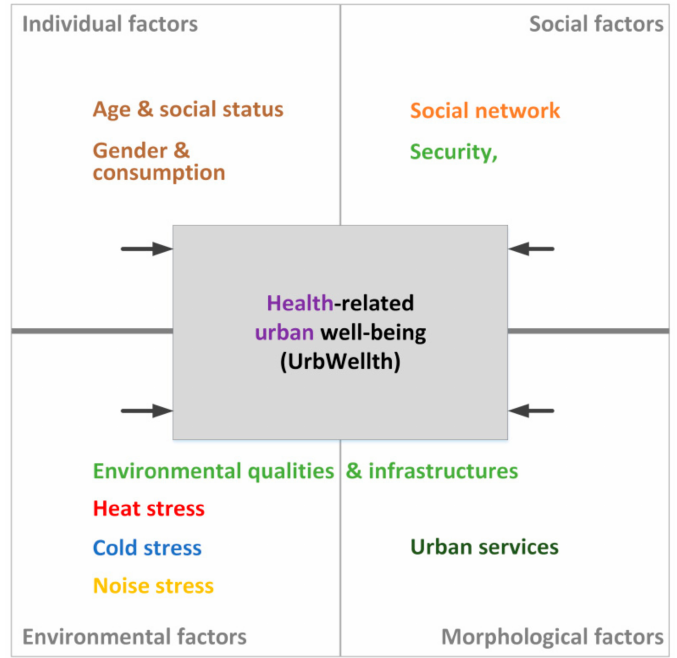
Figure 2. Factors identified by principal component analysis and their relation to